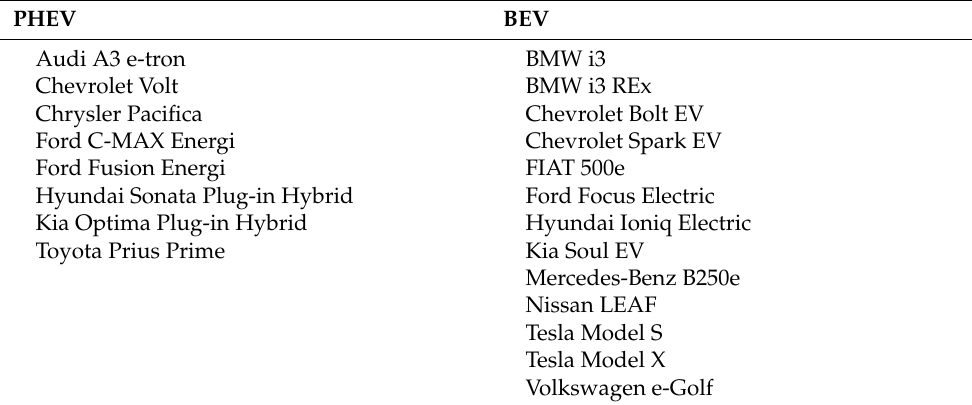
Table 2. EV Models Purchased or Leased by Analyzed Consumers.